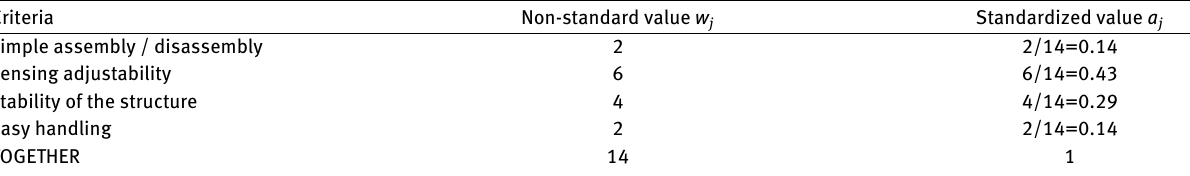
Table 2: Standardized criteria values